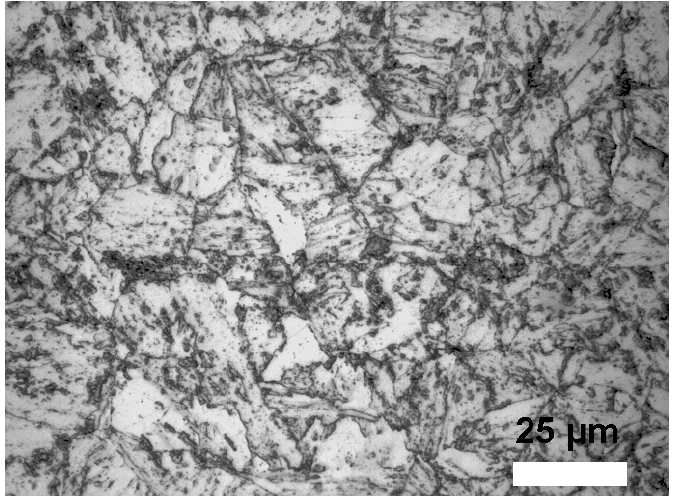
Figure 1: Optical micrograph of the bainitic steel used in the current work. The micrograph was obtained at 1000X magnification.